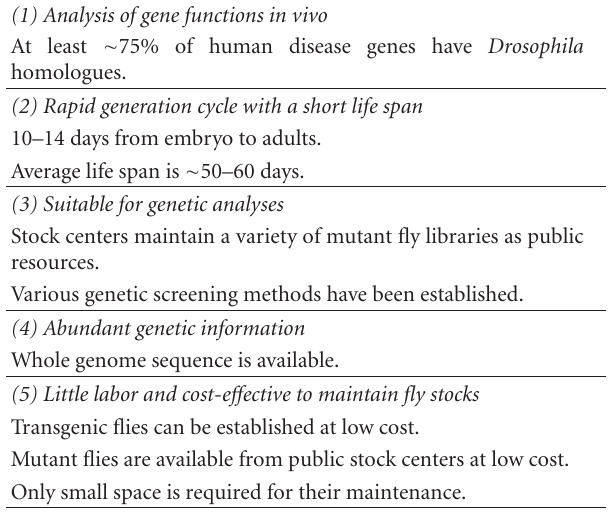
Table 1: Advantages of using Drosophila for modeling human neurodegenerative